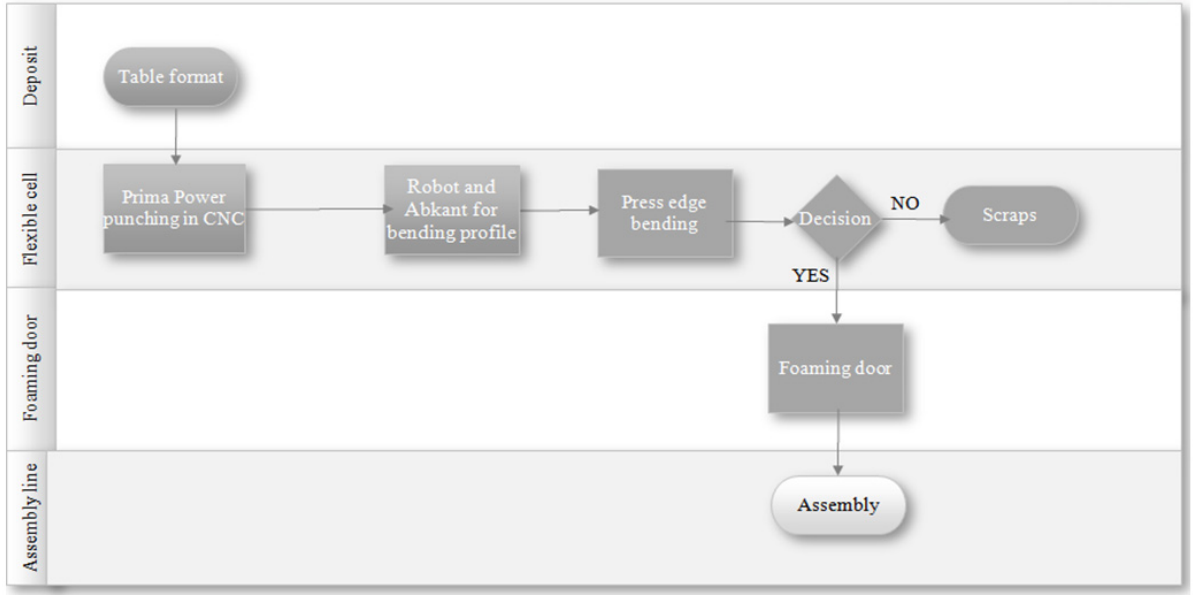
Figure 3. The process map.